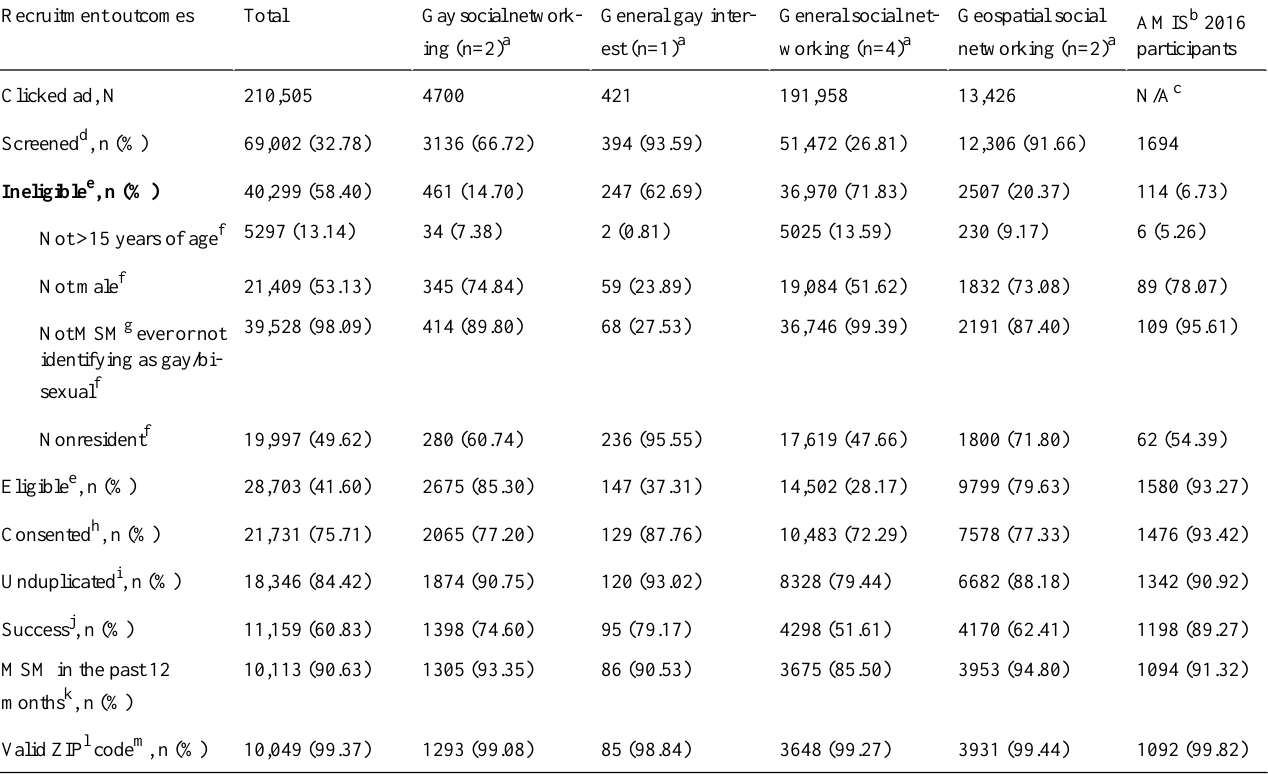
Table 1. Recruitment outcomes for the American Men’s Internet Survey, United States,